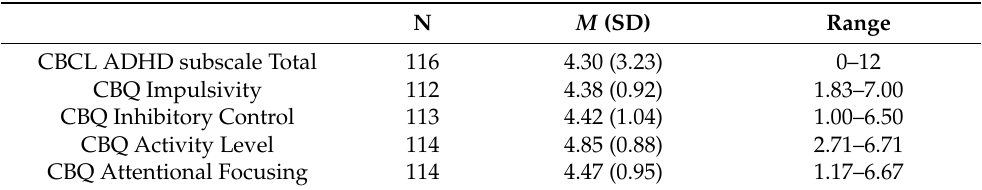
Table 3. Descriptive statistics for Child Behaviour Questionnaire (CBQ) and CBCL at 3 years for the full cohort a .